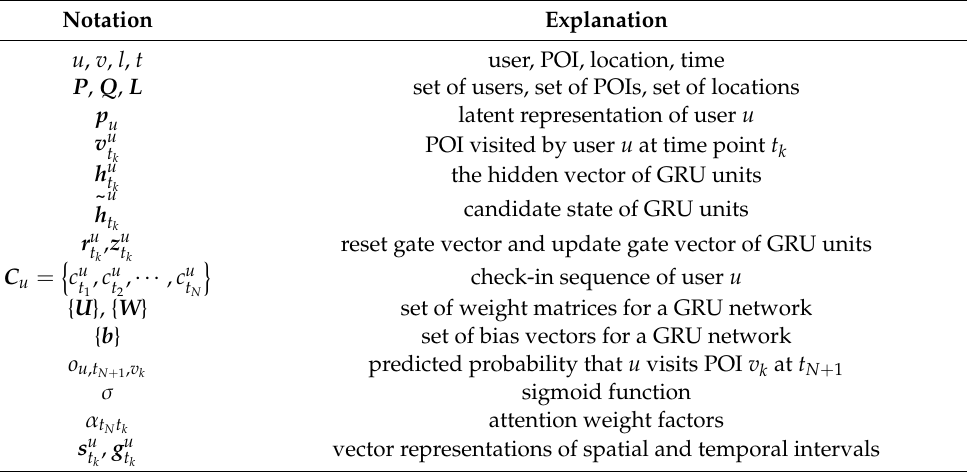
Table 1. Notations in this